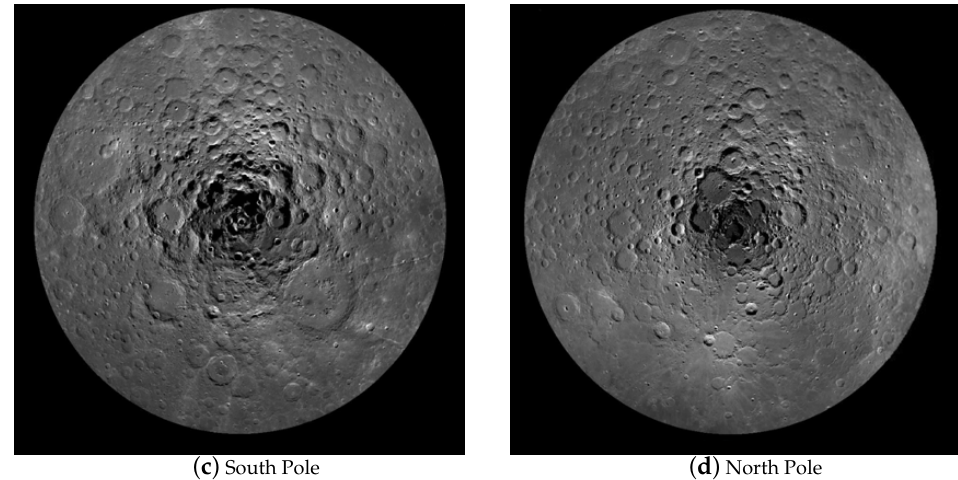
Figure 3. Schematic diagram of the QuickMap Moon